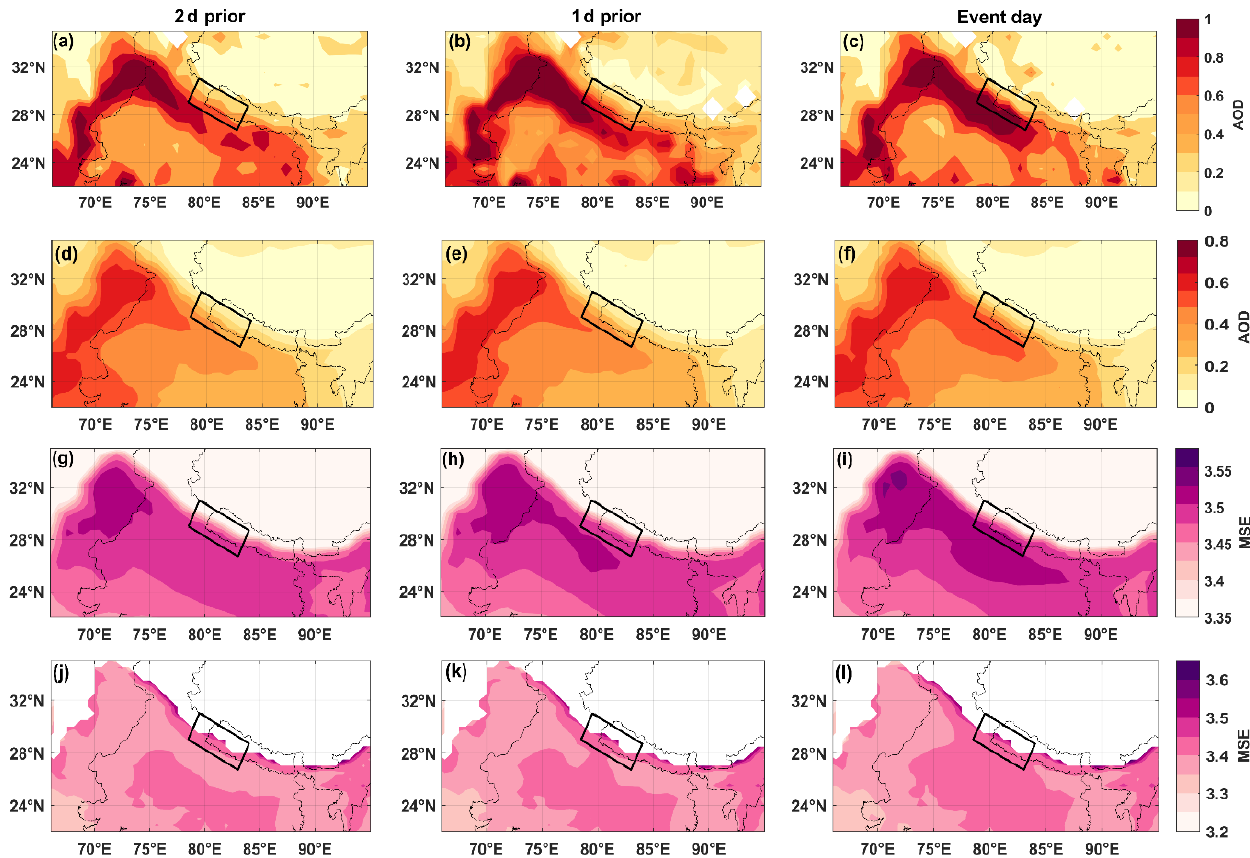
Figure 2. Composites of MODIS AOD (a–c) , MERRA-2 AOD (d–f) , ERA-Interim lower level MSE (g–i) , in units of 10 5 Jkg − 1 , and MERRA-2 lower level MSE (j–l) , in units of 10 5 Jkg − 1 , for the event days (c, f, i, l) and 1d prior (b, e, h, k) and 2d prior (a, d, g, j) to the events.